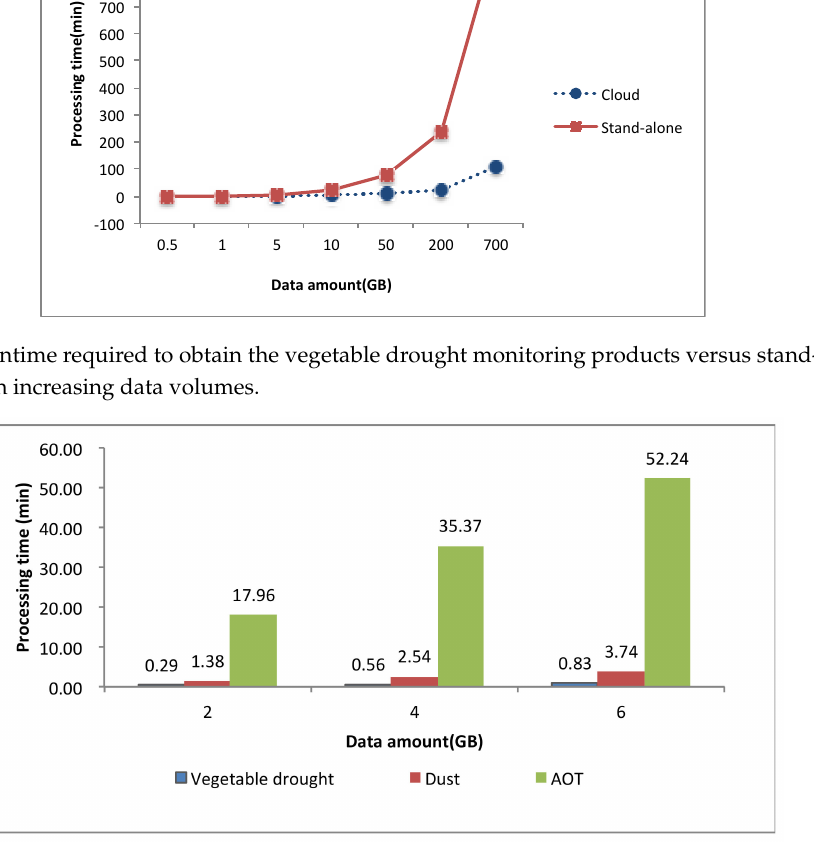
Figure 4. Processing times of various models on Hadoop with 10 nodes as the amount of data increases from 2 to 6 GB.